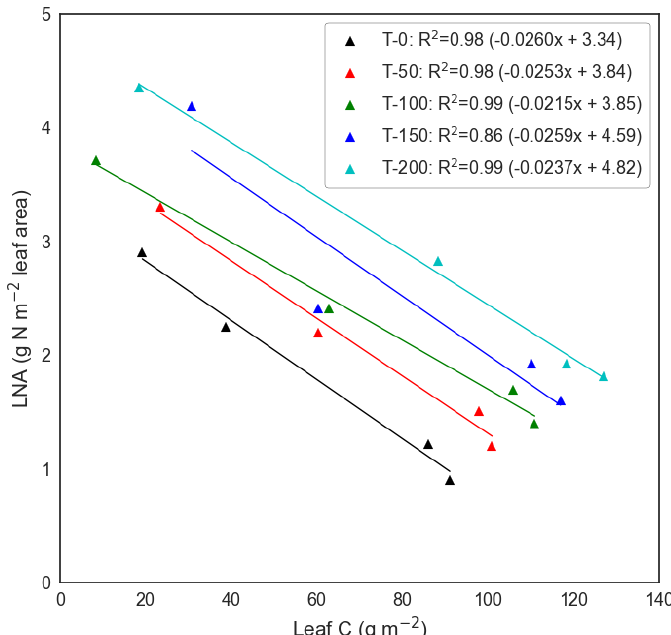
Figure 3. Analysis of leaf nitrogen per leaf area (LNA) against C leaf (leaf C per ground area) based on destructive sample analysis at each of the N treatment plots (T − 0 to T − 200 kg N ha − 1 ) during the 2018 wheat growing season. Derived linear regression coefficients were used within the DALEC-Crop model to calculate LNA. Note: Each LNA — Leaf C point is derived from the mean of two replicated destructive samples.